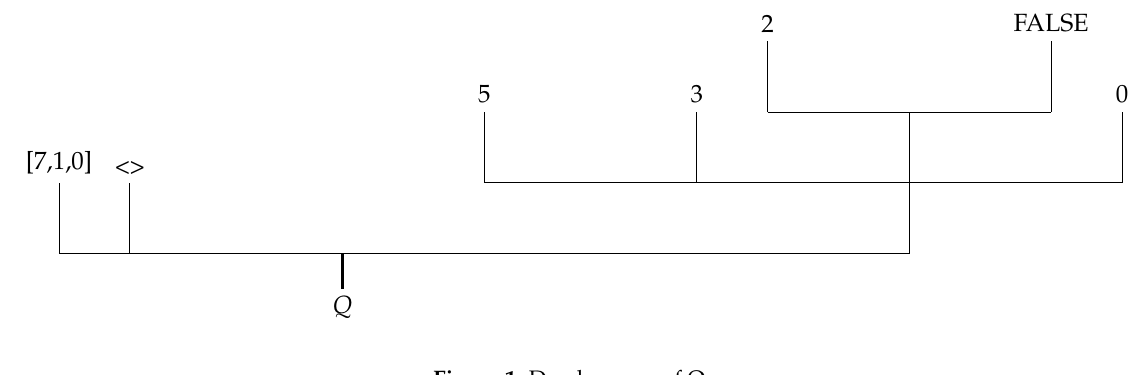
Fig1.Dendrogram of Q Figure 1. Dendrogram of Q.